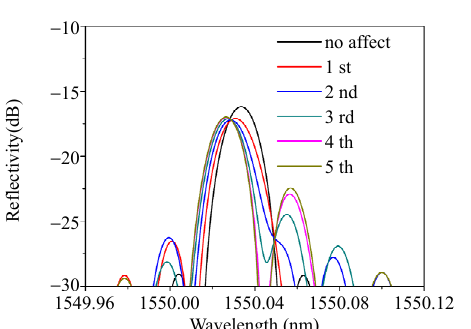
Fig. 7 Change of the reflection spectrum of the SFG with different positions of the sub-grating.